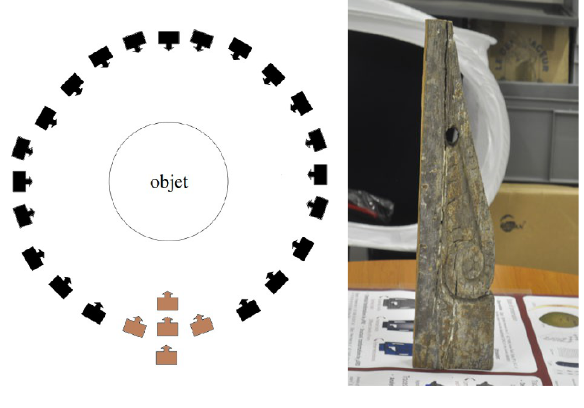
Figure 1. The diagram of Figure 2. Wooden